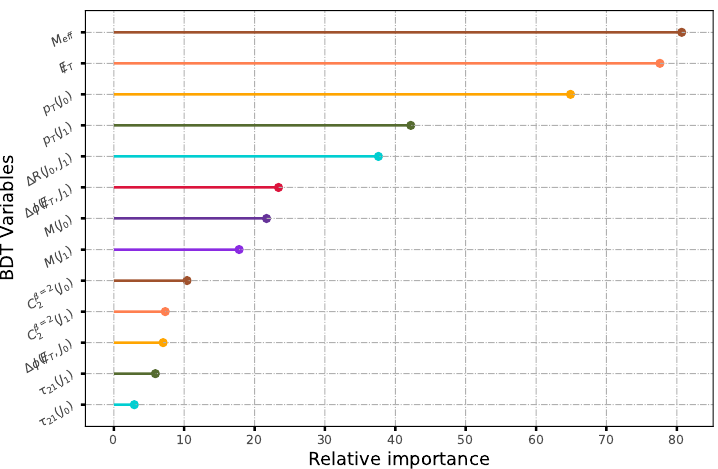
Figure 5 . Kinematic variables used for our MVA and their relative importance. We obtain these using numbers from the TMVA package for the benchmark point. Here, we show method unspeci(cid:12)c relative